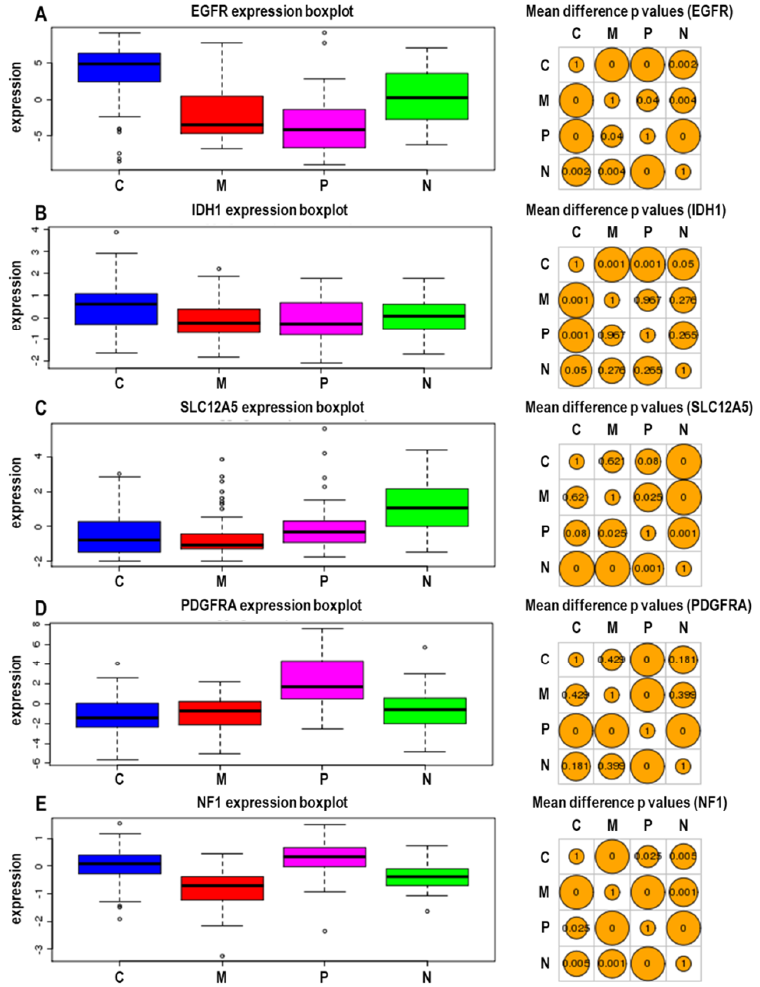
Figure 1. Relative gene expressions in four subtypes of GBM. Relative mRNA expressions (left) and mean difference p values between each subtype (right) of EGFR ( A ), IDH1 ( B ), SLC12A5 ( C ), PDGFRA ( D ), and NF1 ( E ). These data were derived from GBM-BioDP software [10]. C—classical; M—mesenchymal; P—proneural; N—neural.